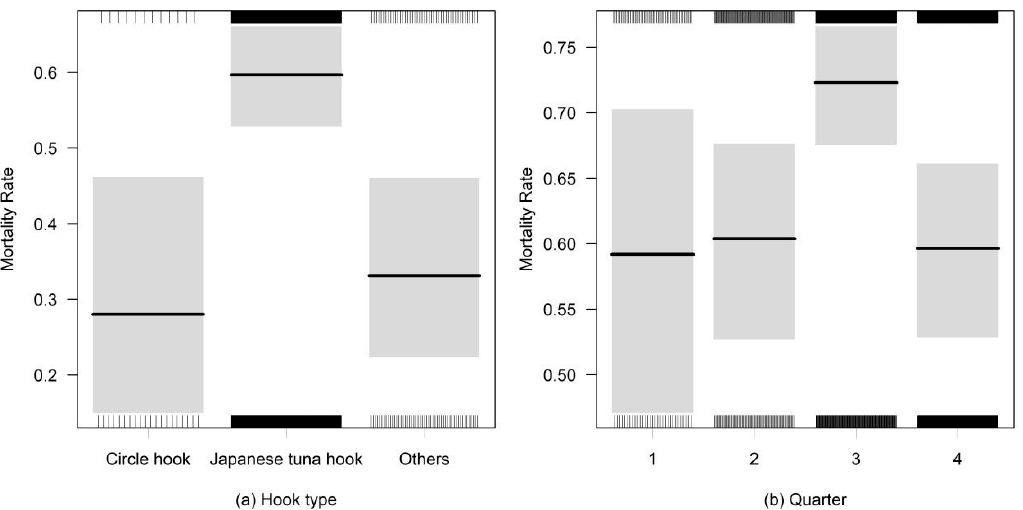
Figure 3. The impact of different hook types ( a ) and different catch quarters ( b ) on the at-haulback mortality of Indian Ocean swordfish. The black solid line represents the predicted probability of death of the hook type, and the gray shaded represents the 95% confidence interval of the categorical variable. The short line segments at the top and bottom indicate the number of fish species under different classifications of the variable. The top indicates the number of deaths, and the bottom indicates the number of survivors.